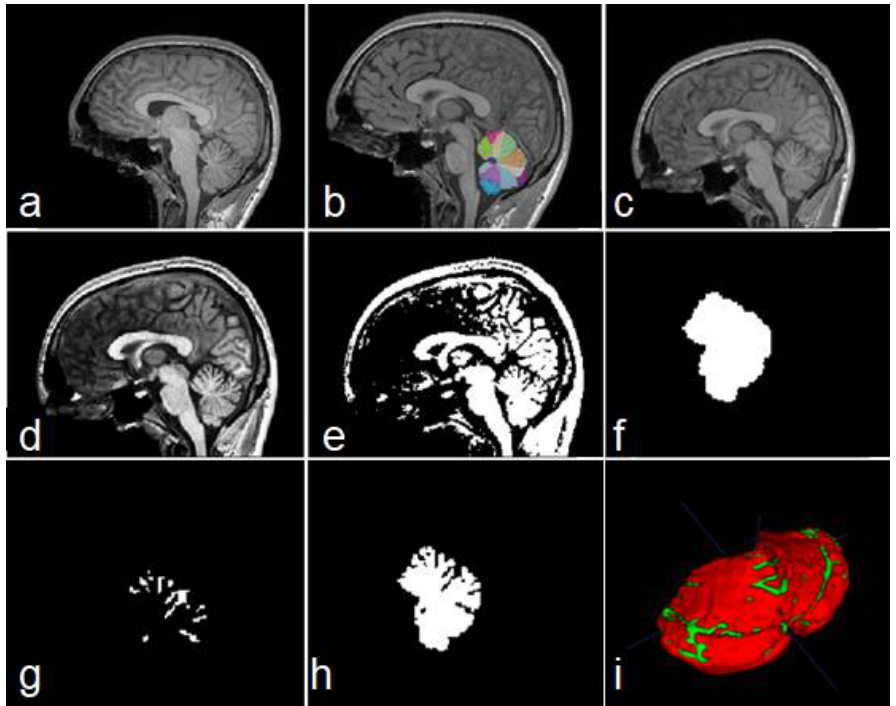
Figure 3. Steps of data construction procedure. Sagittal views of the original image ( a ), cerebellar mask obtained with ACAPULCO ( b ), result of BFC and registration ( c ), contrast-enhanced image ( d ), binary image obtained ( e ), feature map containing the whole cerebellar tissue ( f ), obtained fissures mask ( g ), and cerebellum with fissures ( h ). In ( i ) a 3D view of the union of ( g ) and ( h ); red color represents the cerebellar tissue, and green color shows the fissures.